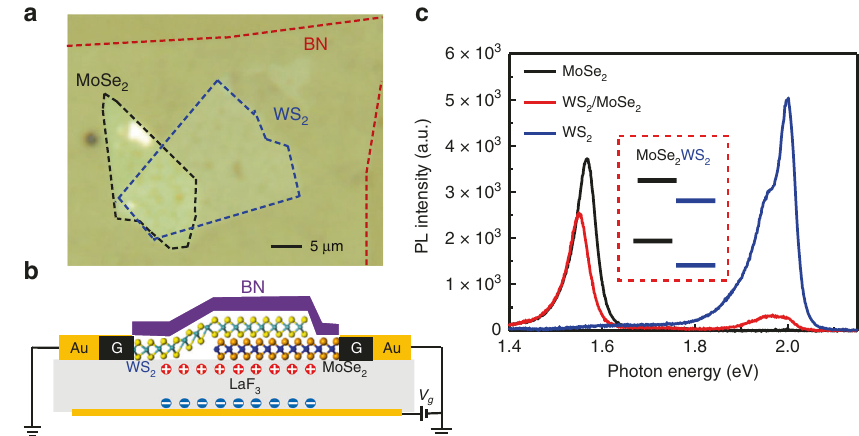
Fig. 1 Monolayer MoSe 2 /WS 2 heterostructure device. a Optical microscopic image of the monolayer MoSe 2 /WS 2 heterostructure, capped with a few- layer h-BN layer. Scale bar: 5 µ m. b Schematic of the MoSe 2 /WS 2 heterostructure device, contacted by few-layer graphene electrodes and gated by the ionic substrate LaF 3 . c Typical room temperature PL spectra from regions of the monolayer MoSe 2 (black), monolayer WS 2 (blue), and MoSe 2 /WS 2 heterojunction (red), with no gate voltage applied. Inset: schematic representation of the type II band alignment of the MoSe 2 /WS 2